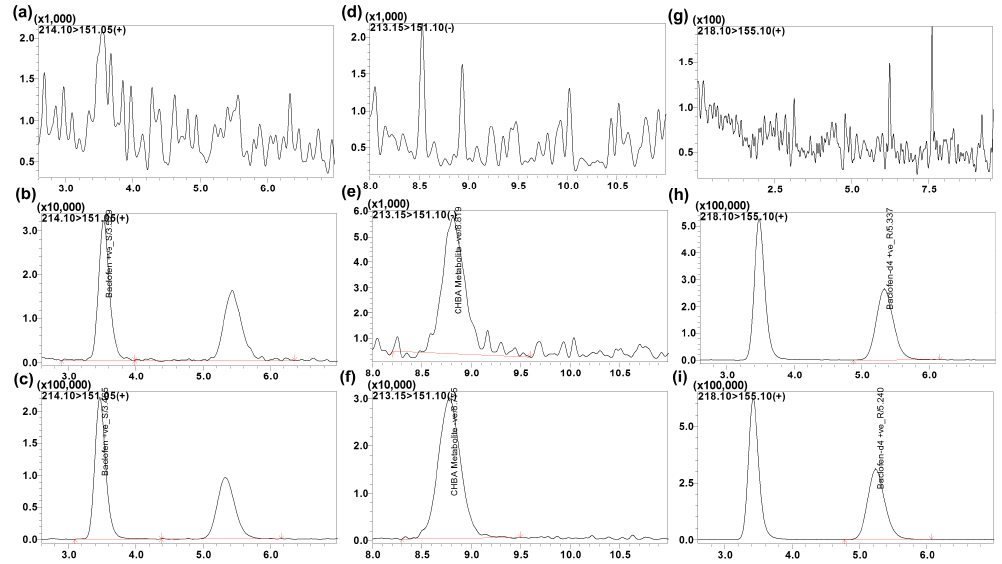
Figure 3. Representative multiple reaction monitoring (MRM) ion chromatograms of ( a ) blank plasma using the conditions for baclofen, ( b ) plasma spiked with baclofen showing the two isomers (S-isomer 3.5 min and R-isomer 5.4 min at 5 ng / mL), ( c ) extracted human plasma sample following baclofen administration showing baclofen isomers, ( d ) blank plasma using the conditions for CHBA metabolite, ( e ) plasma spiked with CHBA metabolite showing the racemic peak for both R- and S-isomers (not separated, 8.7 min, at 5 ng / mL), ( f ) human plasma sample following baclofen administration showing racemic CHBA metabolite, ( g ) blank plasma for baclofen-d4, ( h ) plasma spiked with baclofen-d4 (S-isomer 3.2 min and R-isomer 5.2 min, 1000 ng / mL), ( i ) extracted human plasma sample following baclofen administration and spiked with baclofen-d4.